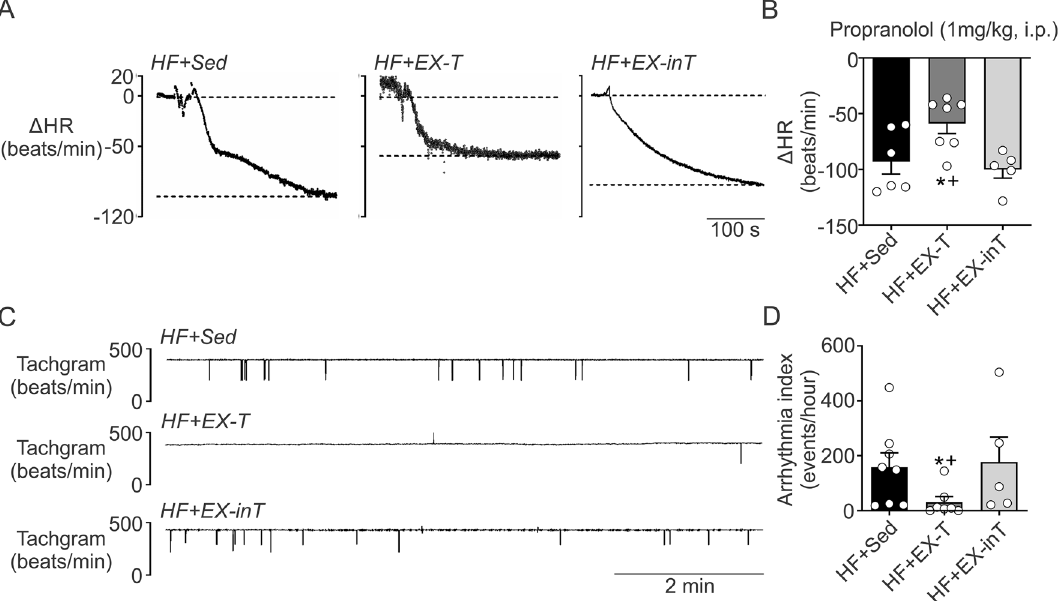
Figure 2. Heart failure rats with exercise training intolerance (HF + EX-inT) displayed similar sympathetic tone and spontaneous arrhythmia incidence compared to sedentary heart failure rats (HF + Sed). ( A ) Representative recordings of heart rate response to propranolol (1 mg/kg i.p.) from one HF + Sed rat, one HF + EX-T rat, and one HF + EX-inT rat. Note that EX did not improve cardiac autonomic control in HF + EX-inT rats. ( B ) summary of the effects of EX on heart rate responses to propranolol. ( C ) representative tachograms from one HF + Sed rat, one HF + EX-T rat, and one HF + EX-inT rat. No beneficial effects of EX on incidence of spontaneous cardiac arrhythmias were found in HF + EX-inT rats. ( D ) Summary of the effects of EX on arrhythmia incidence. *p < 0.05 vs. HF + Sed; + p < 0.05 vs. HF + EX-inT. HF + Sed, n = 6; HF + EX-T, n = 7; HF + EX-inT, n = 5